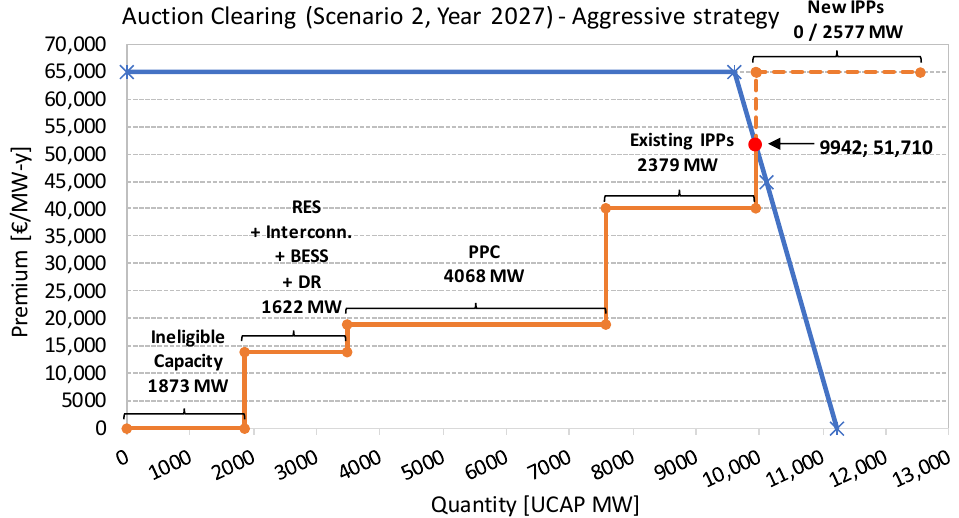
Figure 10. Auction clearing (Scenario 2, Year 2027)–Aggressive strategy.